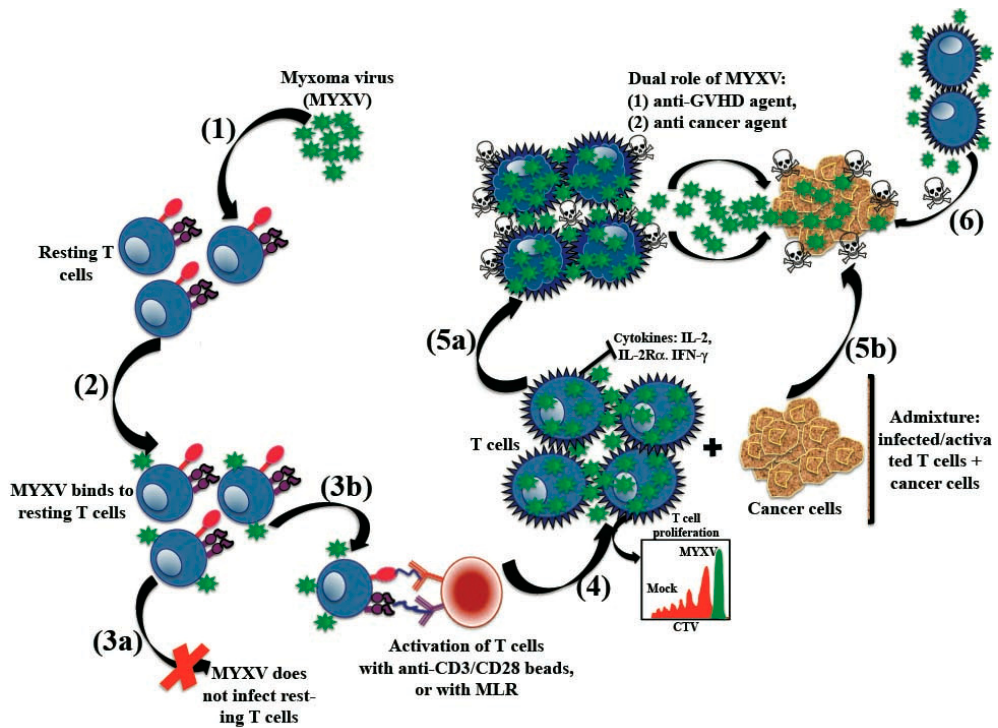
Figure 2. Dual effects of ex vivo virotherapy with myxoma virus: preventing graft- versus -host disease and yet preserving or augmenting graft- versus -cancer. Myxoma virus (MYXV) prevents graft- versus -host disease (GVHD) and improves the graft- versus -cancer (GVC) effects in six steps. (1) MYXV targets and (2) binds to resting human T cells in transplant samples. However, (3a) MYXV infection does not progress past the binding step in resting T cells unless (3b) T cells are stimulated (e.g., via anti-CD3/CD28 beads) or by allostimulation (e.g., via mixed lymphocyte reactions) when contacting allo-antigen in recipient tissues. (4) MYXV impairs T cell proliferation and secretion or endogenous production of inflammatory cytokines that fuel GVHD, including IL-2, IL-2R- α (CD25)